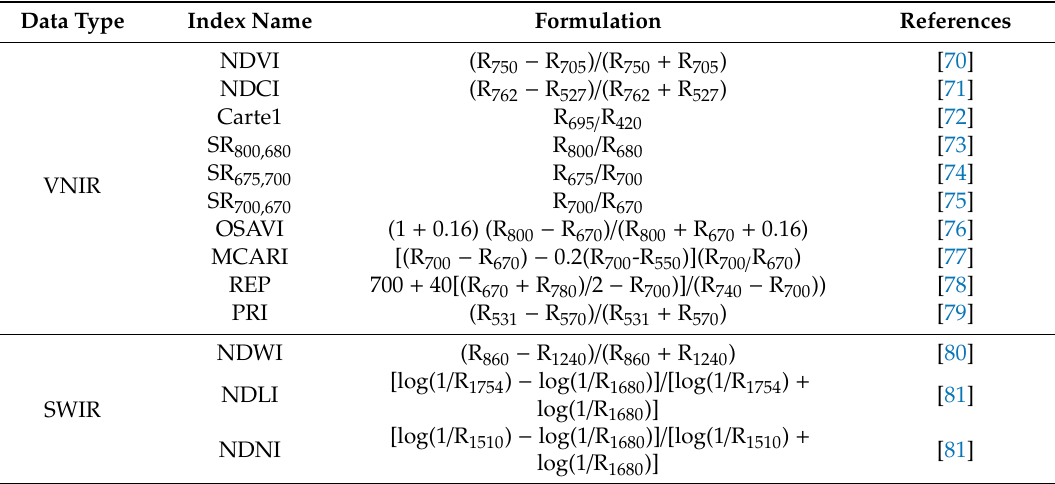
Table A3. Vegetation indices extracted from each HSI spectrum.